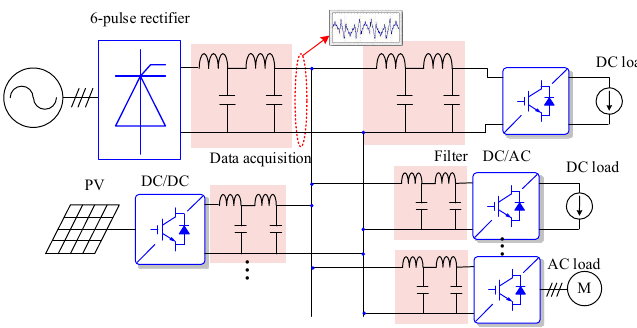
Figure 18. Simulation model of the single-ended radial DC distribution network.